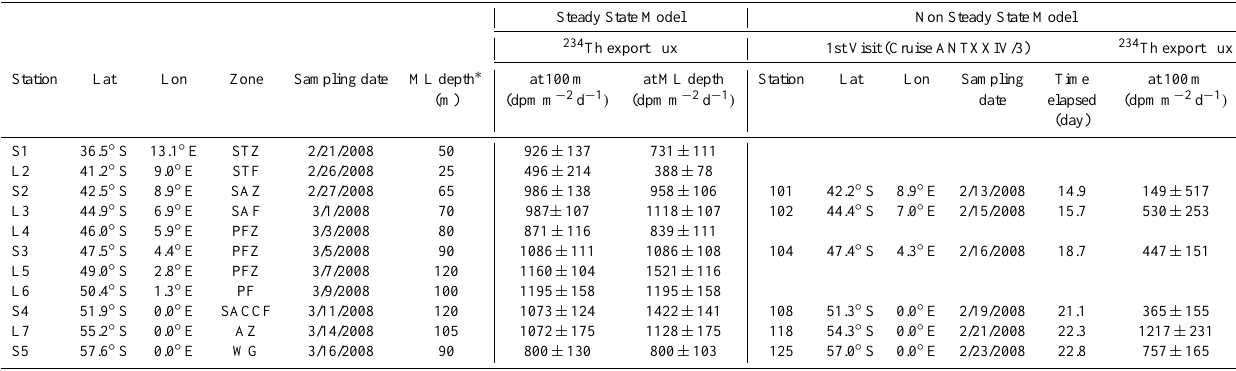
Table 1. 234 Th export fluxes (dpmm − 2 d − 1 ) along the BGH section as calculated using steady state and non steady state models. Uncertainty associated with 234 Th flux is at 95% confidence interval (2 σ) . STZ: subtropical zone; STF: Subtropical Front; SAZ: sub-Antarctic zone; SAF: sub-Antarctic Front; PFZ: polar frontal zone; PF: Polar Front; SACCF: southern Antarctic Circumpolar Current Front; AZ: Antarctic zone; WG: Weddell